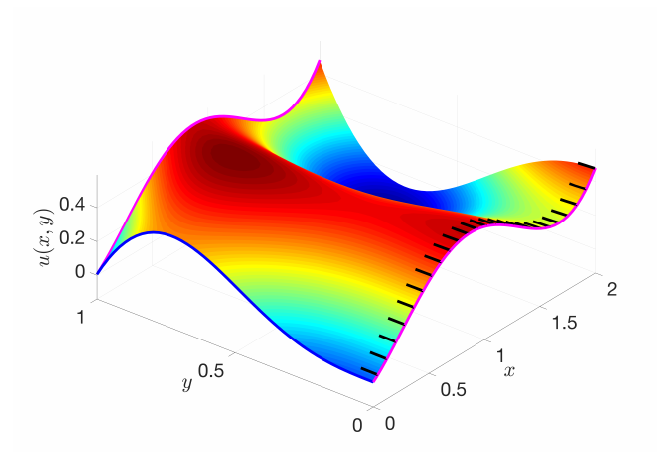
Figure 3. Multivariate example # 2 constrained expression evaluated using g ( x , y ) = x 2 cos y + sin ( 2 x ) . The blue line signifies the constraint on u ( 0, y ) , the black lines signify the derivative constraint on u y ( x ,0 ) and the magenta lines signify the relative constraint u ( x ,0 ) = u ( x ,1 ) . The linear constraint u ( 1, y ) + u ( 2, y ) = y sin ( π y ) is not easily visualized, but is nonetheless satisfied by the constrained